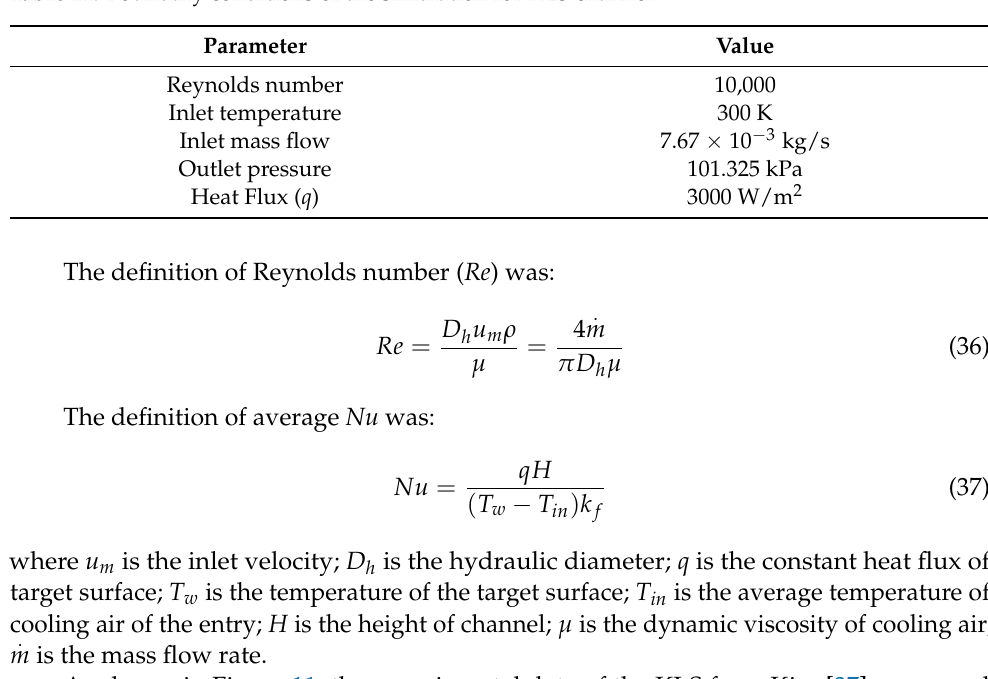
Table 11. Boundary conditions of the simulation for KLS channel.